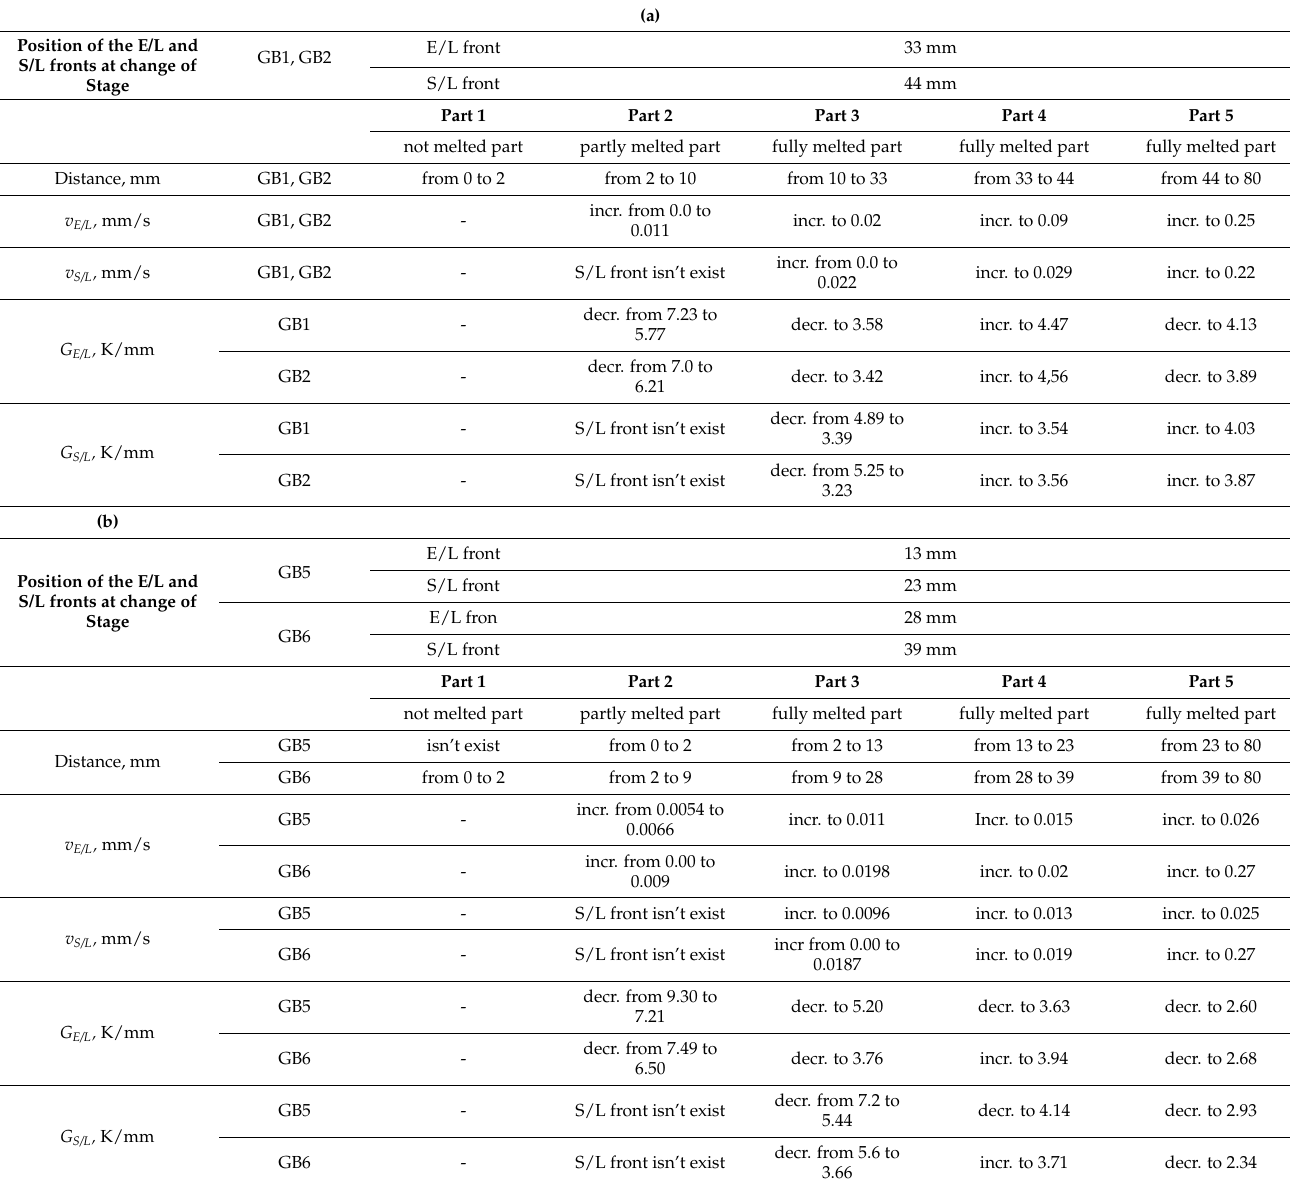
Table 3. (a). The velocities and temperature gradients changing in the different Parts of GB1 and GB2 samples. (b). The velocities and temperature gradients changing in the different Parts of GB5 and GB6